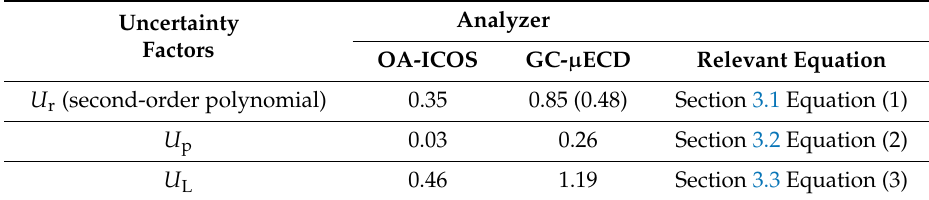
Table 2. Estimated uncertainty factors in the measurements of N 2 O from each instrument. Units are ppb. All terms have a 68% confidence interval. The values in brackets are derived from the GC- µ ECD applied by the second-order polynomial regression curve. U r : uncertainty of linearity, U p : repeatability, and U L : long-term